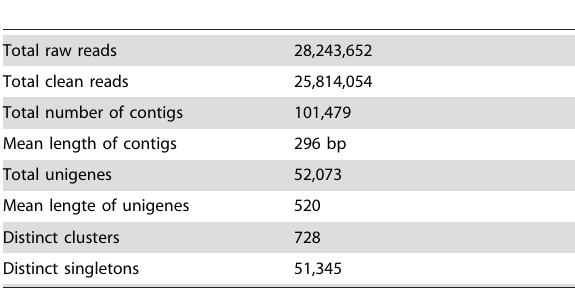
Table 1. Summary of the